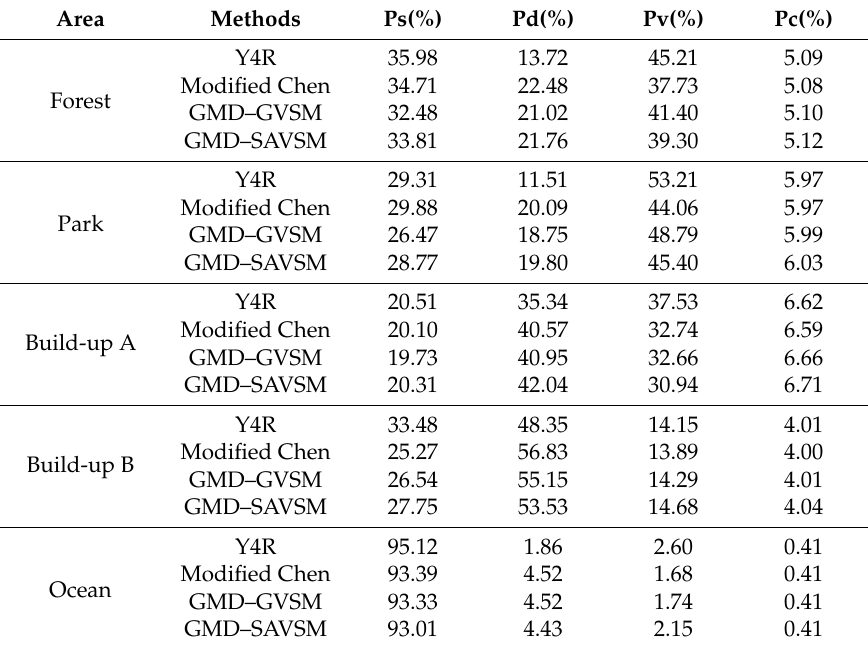
Table 2. Statistics of power of scattering components of Radarsat2 image in selected areas with different land cover